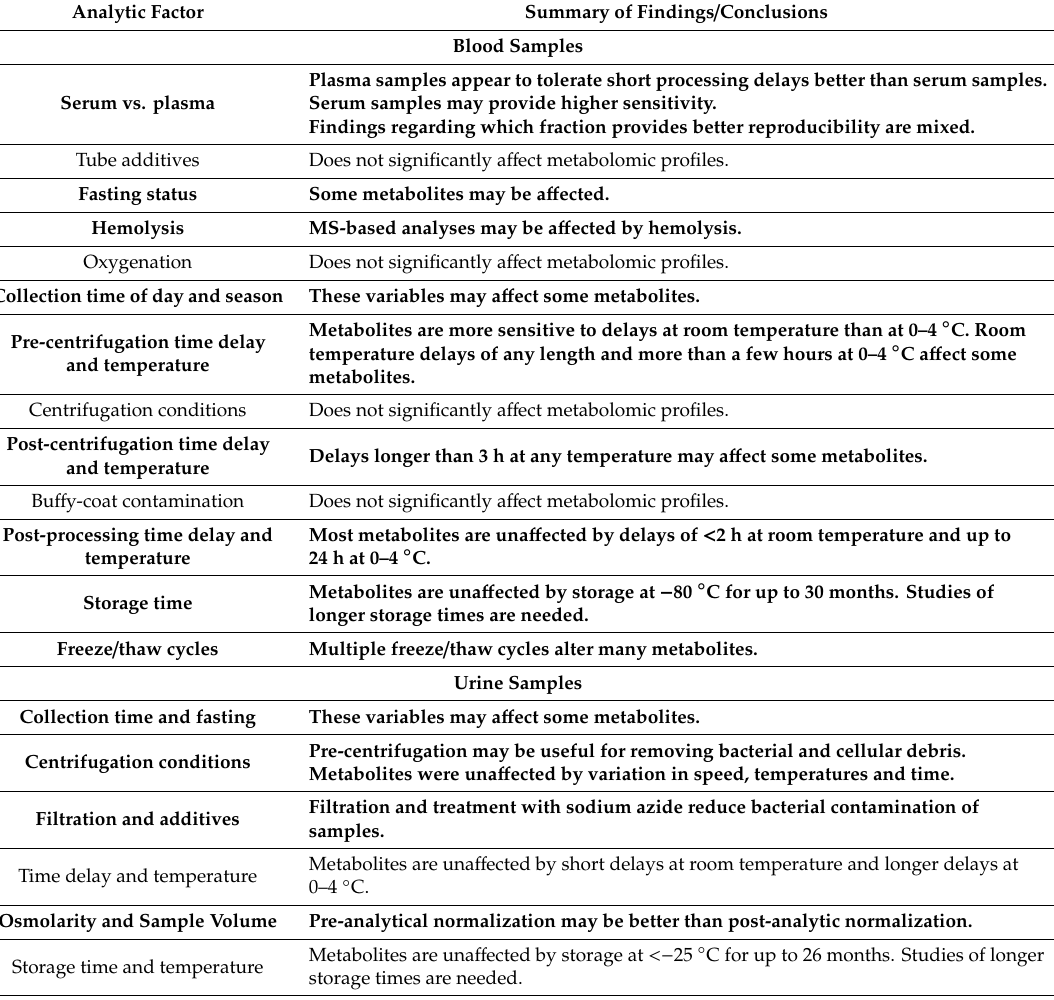
Table 3. Summary of findings. Bold text indicates that the pre-analytical factor may a ff ect metabolomic